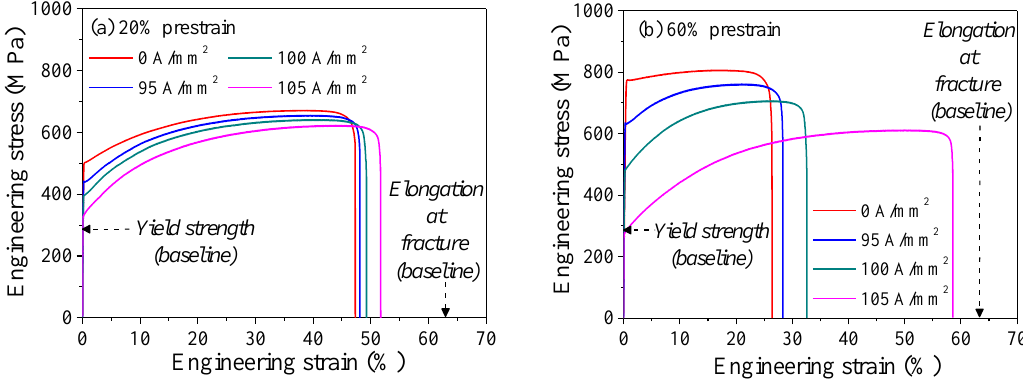
Figure 4. Engineering stress-strain curves after EA annealing with ( a ) 20% prestrain and ( b ) 60% prestrain; the engineering stress-strain curves during reloading was constructed based on the gage length and the cross-sectional area at each prestrain.